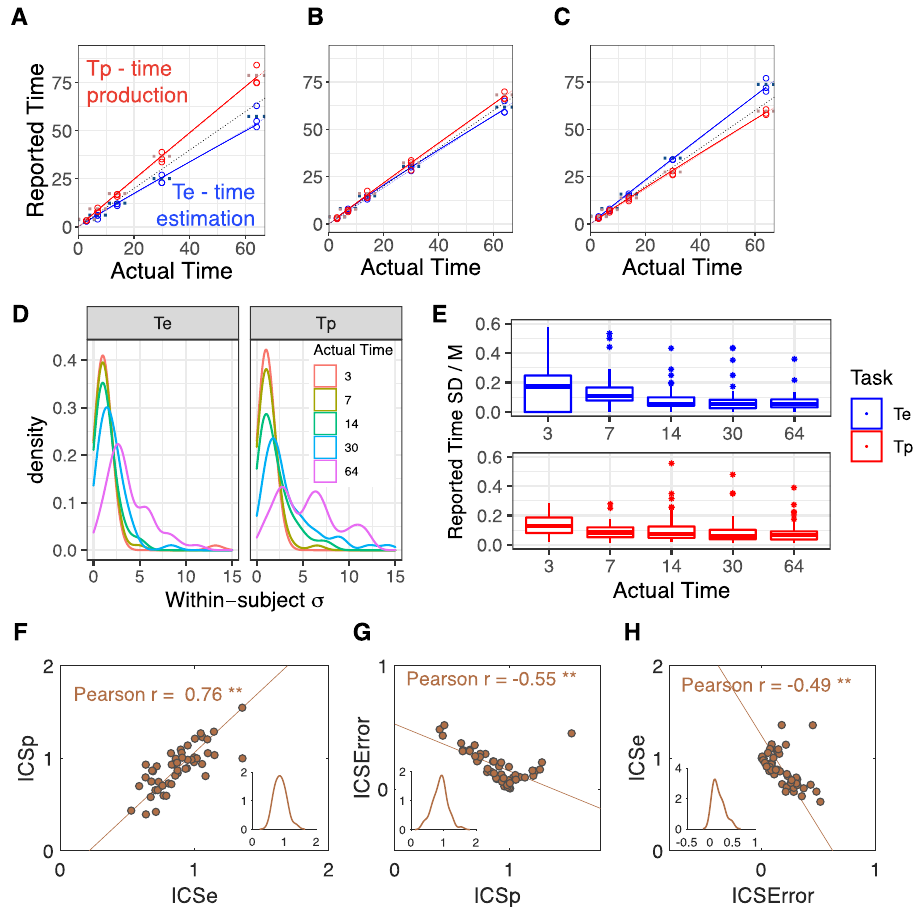
Figure 3. ( A – C ) Reported versus actual time for three example subjects. Circles correspond to individual trials and the horizontal dotted line shows the mean per interval (Production, red; Estimation, blue). y = x is drawn in dotted gray. The solid and dashed lines of each color are the power and the linear fits, respectively. If the estimation time was slower (blue below y = x ) and the produced time was faster (red above y = x ) than a stopwatch that was consistent evidence for a lower ICS. A subject with ( A ) low ICS, ( B ) accurate ICS & ( C ) high ICS. ( D ) Subjects showed scalar timing. Distribution of within-subject standard deviations grouped by the type of timing task and actual time interval ( N = 50 subjects in each density plot with outlier trials removed, “Methods”). See also Fig. S5 and Table S1 in SI. ( E ) Boxplots of SD/M for each duration. The SD/M was stable across durations, consistent with scalar timing (Production, red, two outlier points were truncated; Estimation, blue, eight outlier points were truncated). ( F – H ) Scatter plots ( N = 49 ) between ICSe , ICSp and ICS error with TLS regression lines. Significant correlation between ICSe & ICSp measures indicates that the tasks reliably captured between subject variability in ICS. Inset: kernel density estimation of respective timing variable